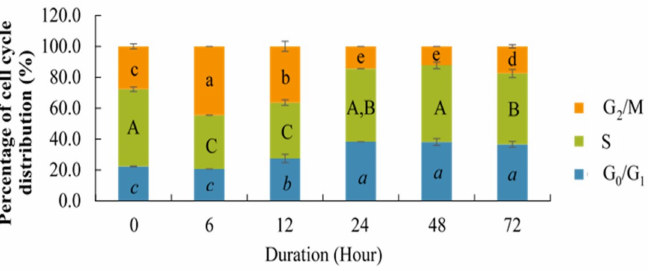
Figure 3. Changes in the percentage of HCT 116 cells in G 0 /G 1 , S, and G 2 /M phases at different durations following treatment with 10.54 µ g/mL berberine. Values are mean ± standard error of triplicate. Mean with different letters differ significantly at p < 0.001 (subject to different cell cycle